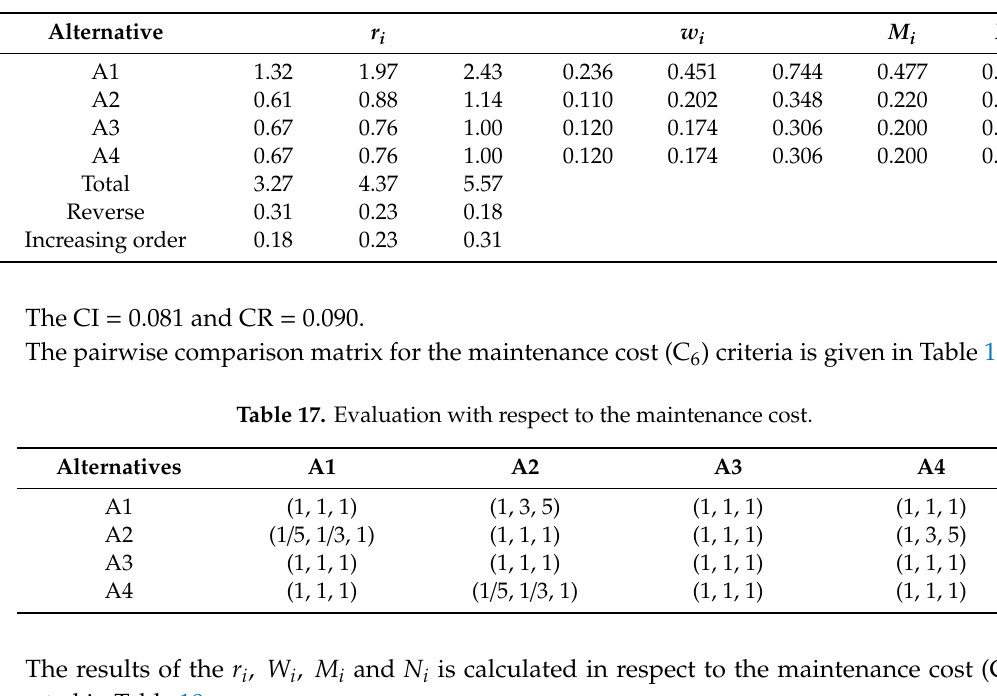
Table 16. Results of r i , W i , M i and N i in respect to the exploitation time.